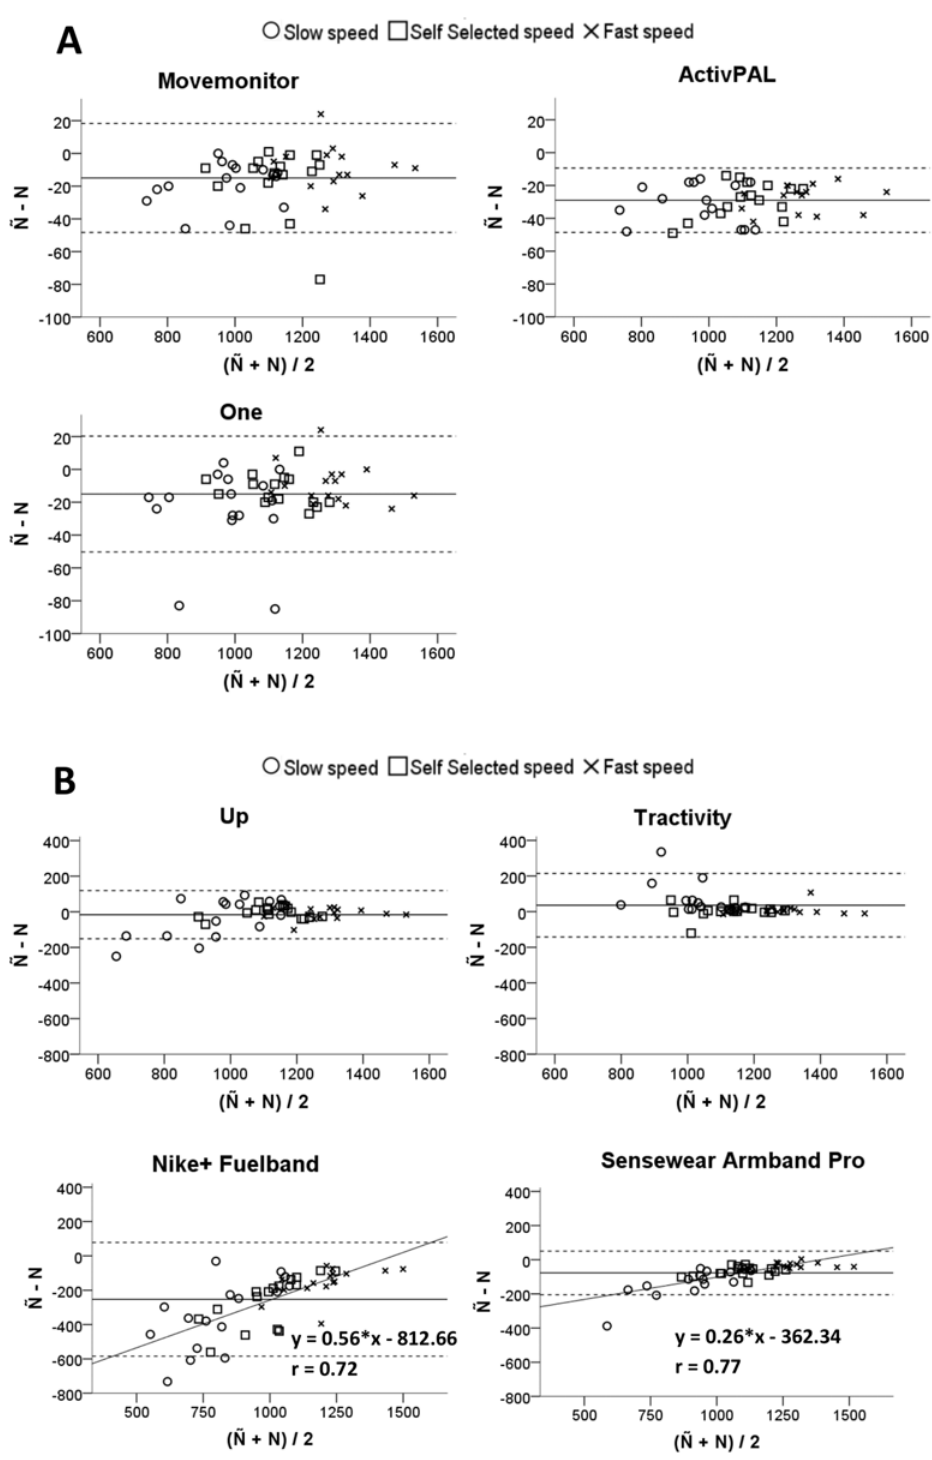
Fig 4. Bland-Altman plots for step count for (a) the Movemonitor, ActivPAL and One, and (b) for the Up, Tractivity, Nike+ Fuelband and Sensewear Armband Mini. The solid lines indicate the mean step count difference between the OPAL sensor and each monitor. The dashed lines indicate mean ± Limits of Agreement (1.96 * SD). Regression lines, relevant equations and Pearson ’ s correlation coefficients (r) are shown for the Nike+ Fuelband and the Sensewear Armband